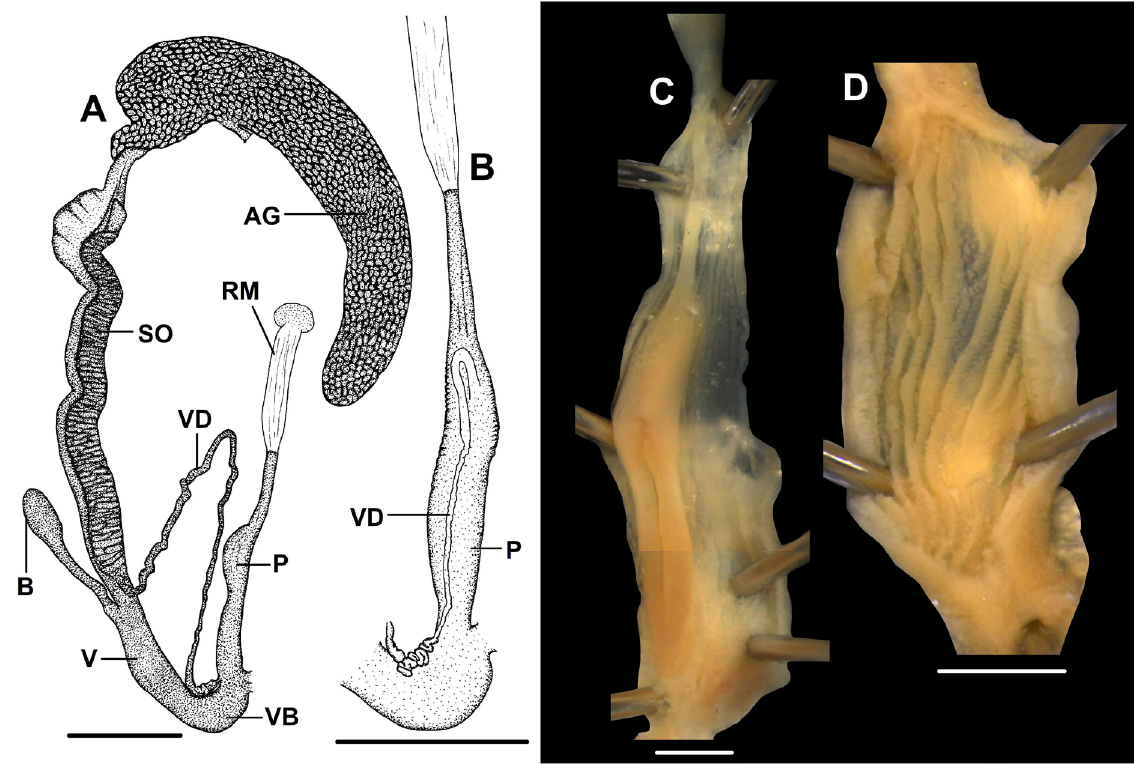
Fig. 33. Genitalia of Hunyadiscus tigrina sp. nov., Thailand (UF 343844). A . Whole genitalia. B . Male genitalia (penis and vas deferens). C–D . Inner structure of genital organs (C = penis, D = vagina). Scale bars: A–B = 2 mm; C–D = 1 mm. For abbreviations see Fig. 2. All photos: B.